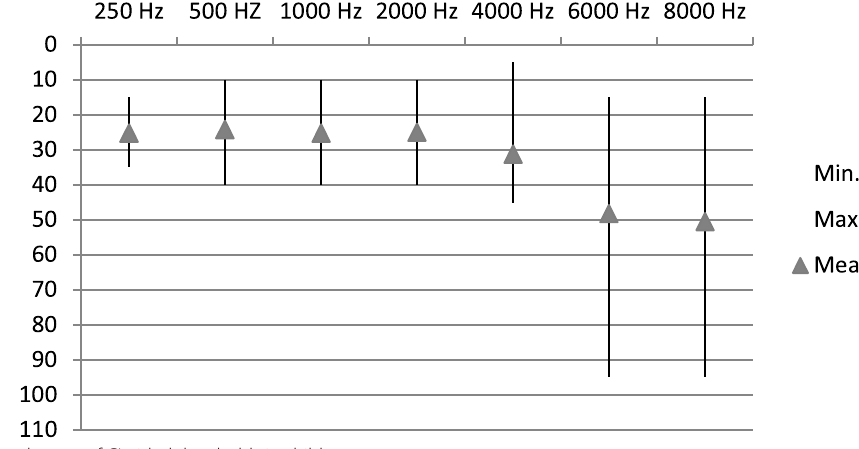
Fig. 5 The mean and range of CI-aided thresholds in children